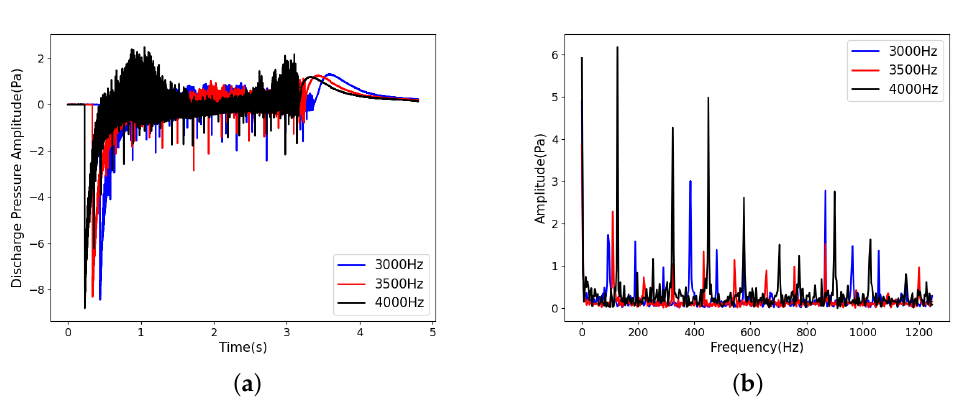
Figure 5. ( a ) Pressure perturbation waveform and ( b ) FFT results at different discharge frequencies.